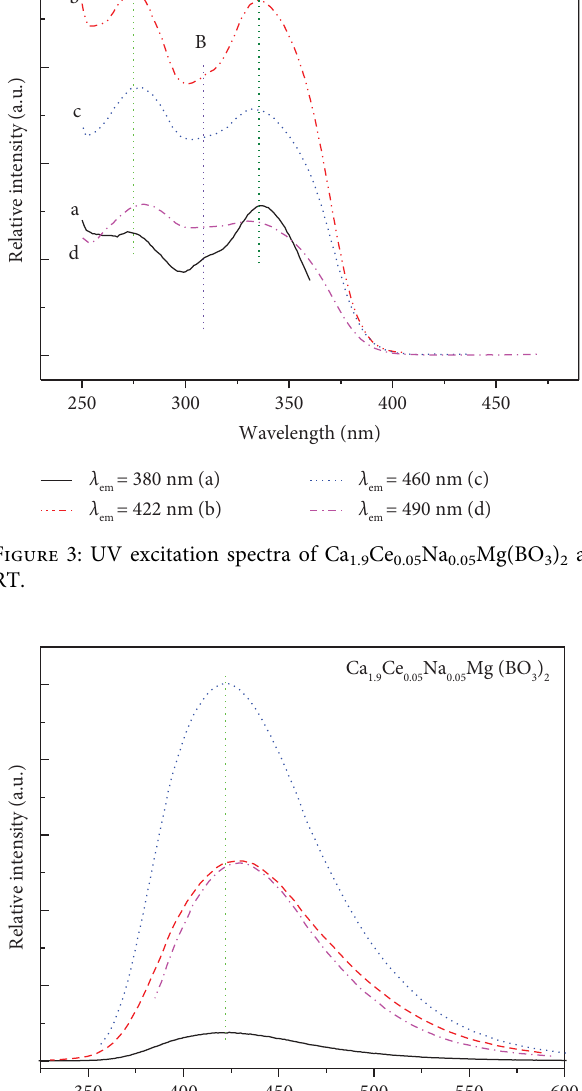
1.9 Ce 0.05 Na 0.05 Mg(BO 3 ) 2